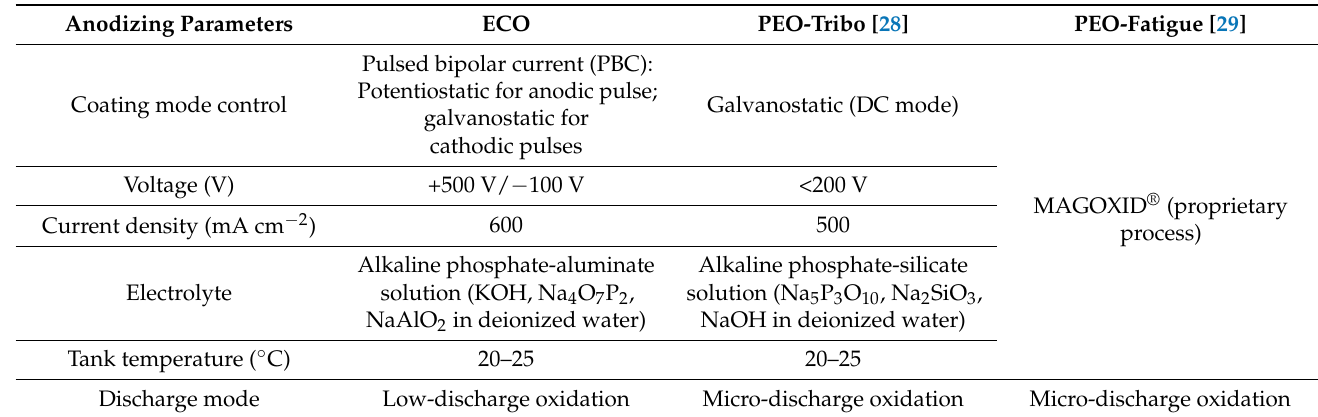
Table 2. Main features of the anodizing treatments.